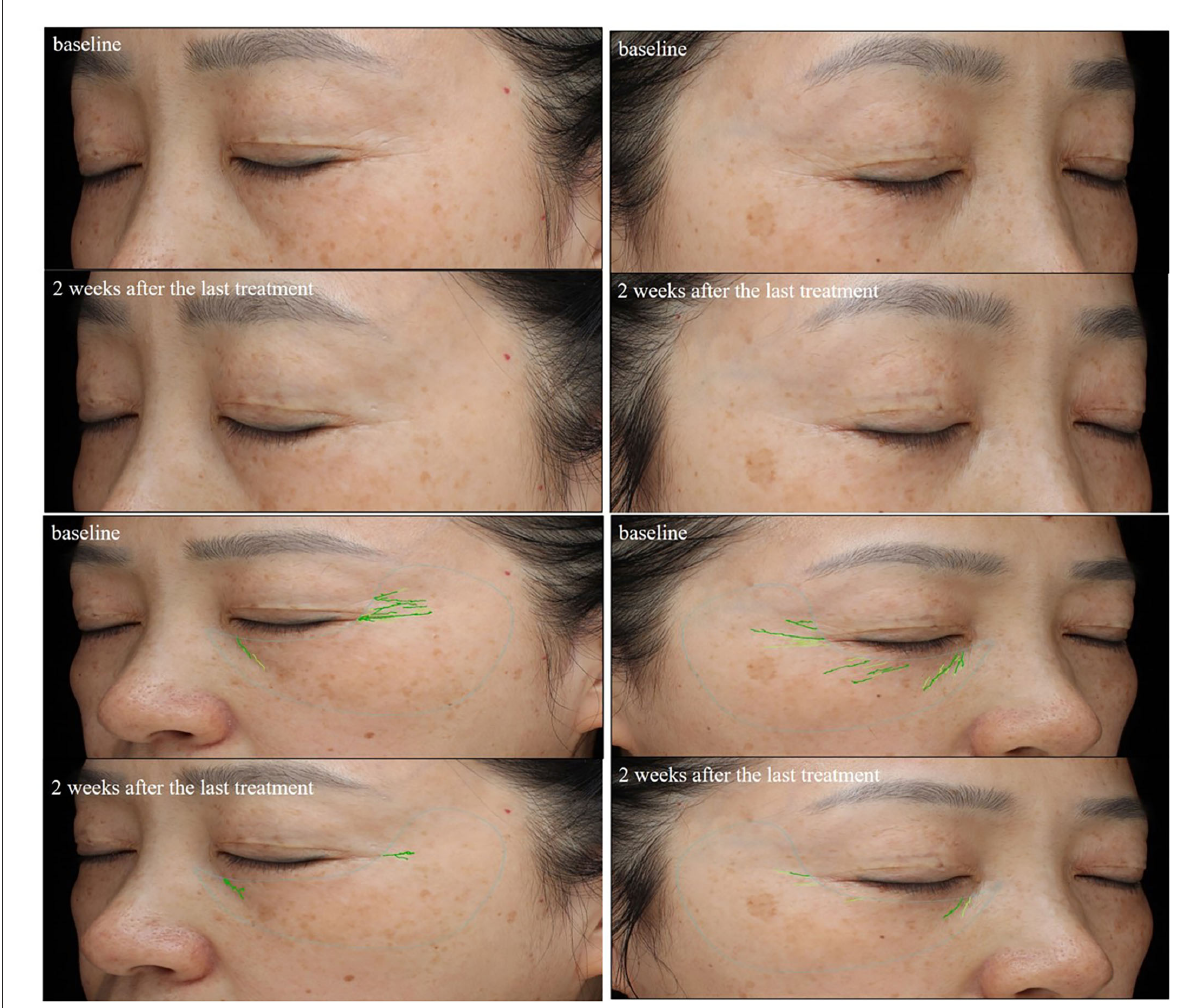
FIGURE3 Comparison of the periorbital wrinkles in a 49-year-old woman based on the VISIA images. Her left periorbital area was treated with ECM-C via MN; the wrinkles score assessed by the VISIA images system decreased from 5.55 to 1.84; her right periorbital area was treated with ECM-C via MN and radiofrequency; the wrinkles score assessed by the VISIA images system decreased from 6.26 to